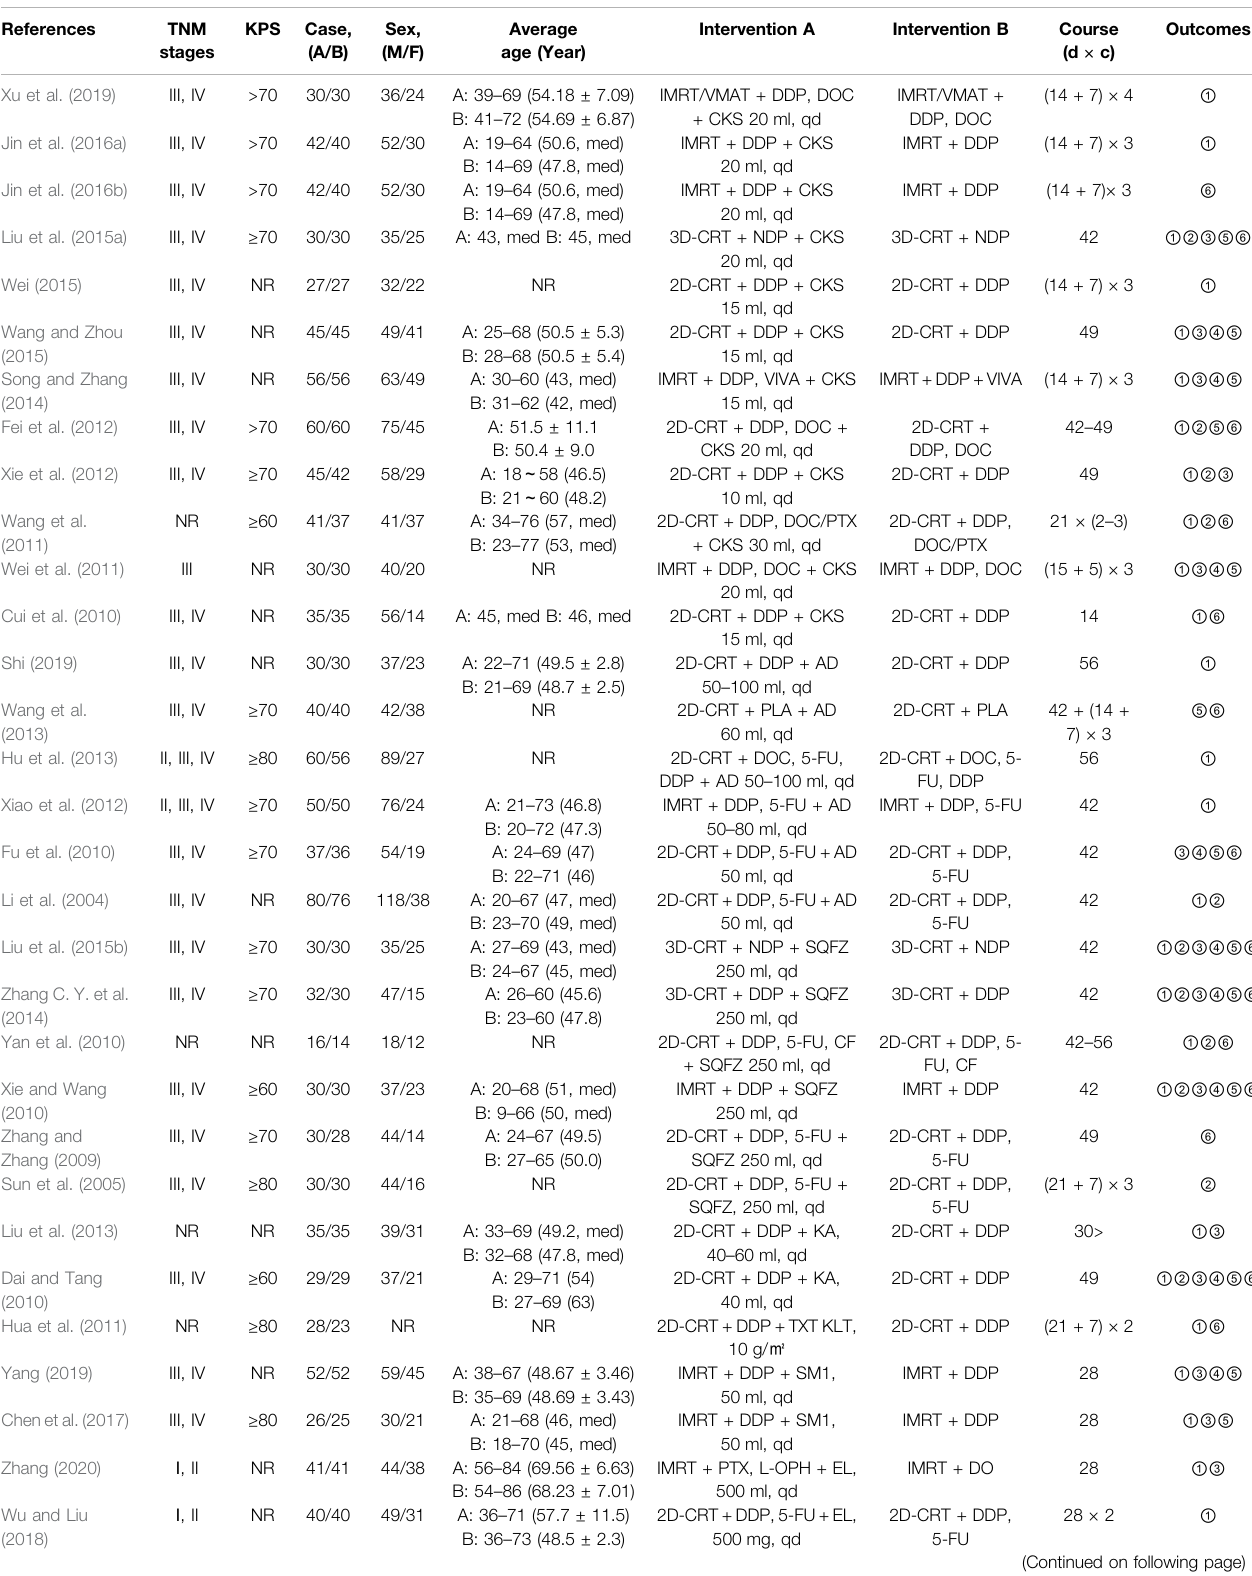
TABLE 1 | The basic characteristics of the included